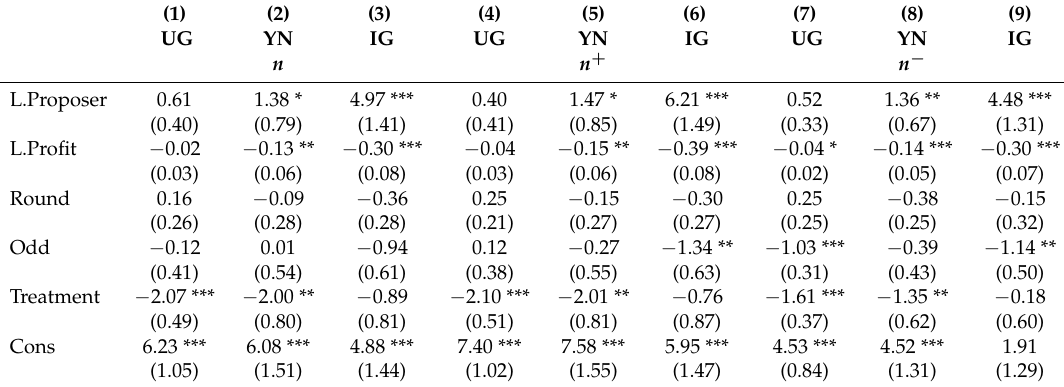
Table 3. Choice dynamic by Game